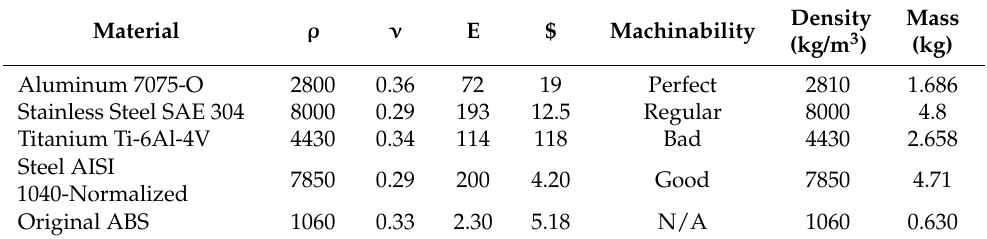
Figure 3. Movement restrictions on top of the spherical shoulder. A load of 5 N was applied to the palm component “X”, whereas the model was in a completely rigid position of 180°. Therefore, it was considered the most critical arm posi- tion (Figure 4) to obtain the reaction forces on each of the joints of the links that set the mechanism. Figure 4. Application of the average load to the “X” axis. Naturally, area containing the ball handler’s shoulder is expected to be the most crit- ical. Therefore, the theory used was the maximum shear stress (TRESCA) because this criterion of static resistance is applied to ductile materials. After all, it has a greater incli- nation for safety. Since the selected material was aluminum 7075- O , Figures 5–7 show the maximum displacement, shear stress, and strain.